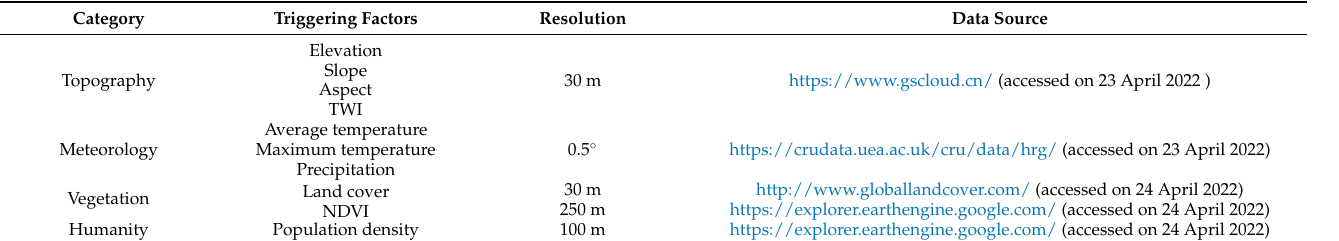
Table A1. Data of each triggering factor.